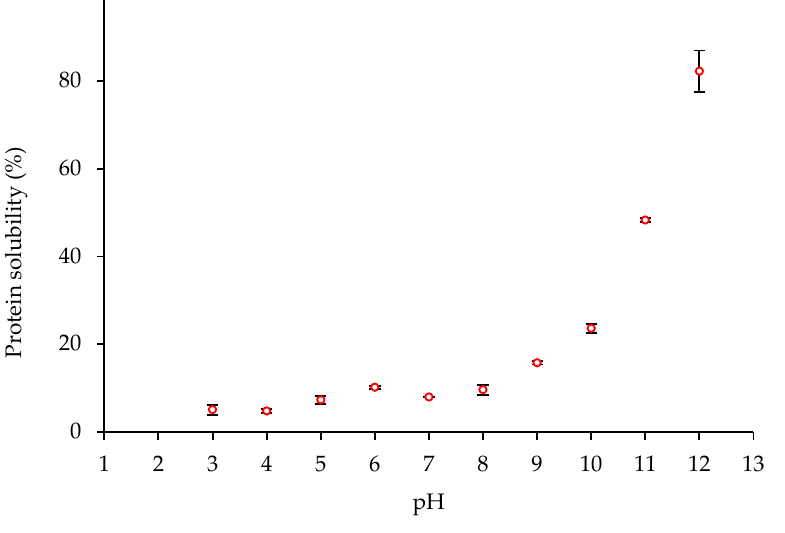
Figure 1. Protein solubility/pH profile of a commercial hempseed protein isolate (HPI) at different pH values. Each point represents the mean ± standard deviation (SD) of triplicate measurements.